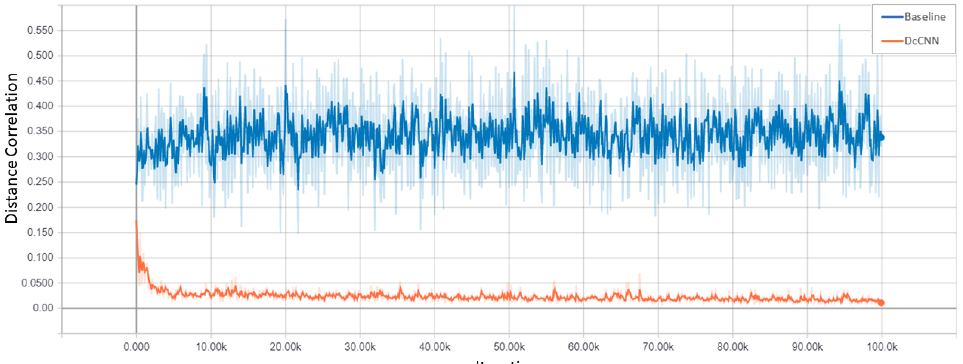
Figure 5. Distance correlation between learned features and bias m 2 for the simulated